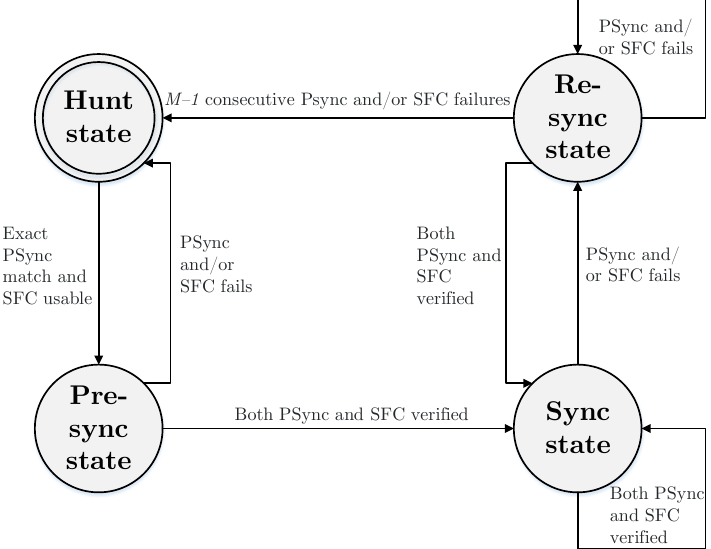
Figure 1. Synchronization state machine for XG-PON downstream